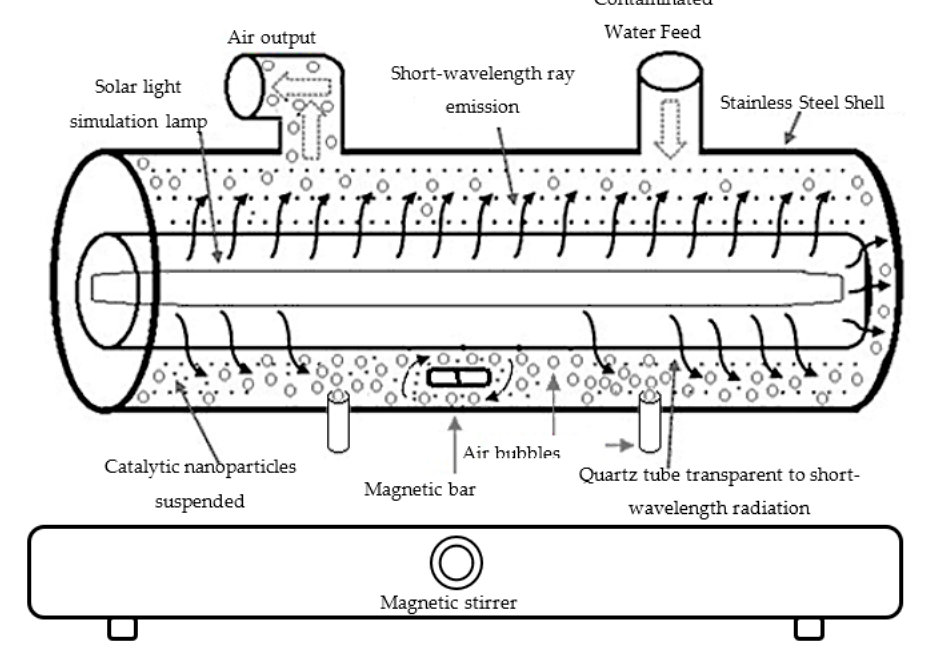
Figure 1. Experimental setup of the heterogeneous photocatalysis reactor.